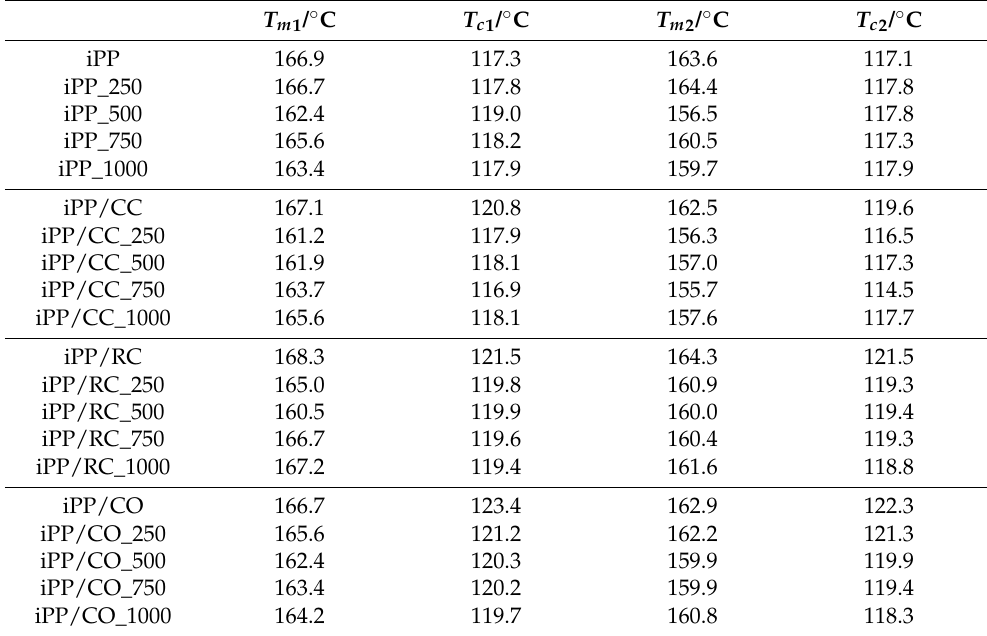
Table 2. Thermal properties of the iPP composites (first and second heating cycles) as a function of accelerated